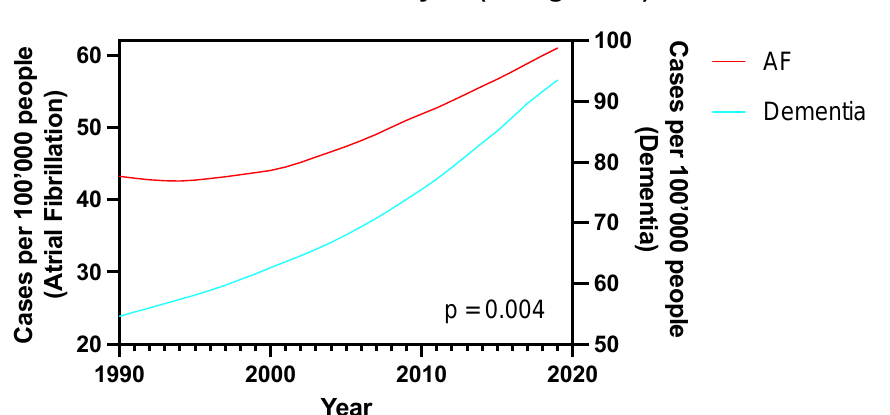
Figure 4. Granger test analysis on the global historical trends (1990–2019) of crude incidence rate of AF and dementia.